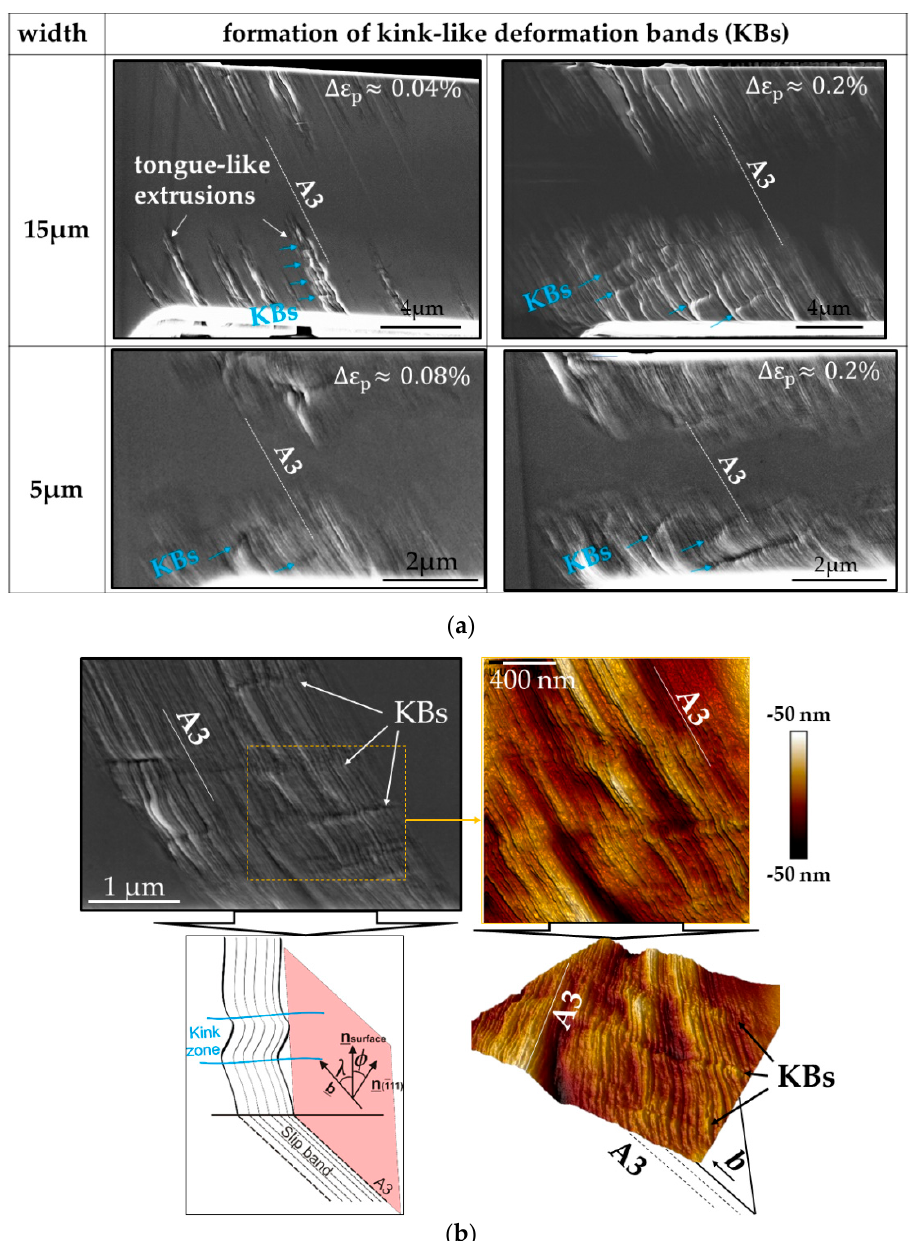
Figure 8. ( a ) SE images of the top surface (surface 1 in Figure 1b) after N = 10 4 cycles of the 15 and 5 µ m beams fatigued with di ff erent strain amplitude ∆ ε p ; ( b ) SE and three-dimensional atomic force microscope (3D AFM) images of an individual PSB on the top surface of a 15 µ m beam, as well as a schematic representation of an individual kink band at emerging slip